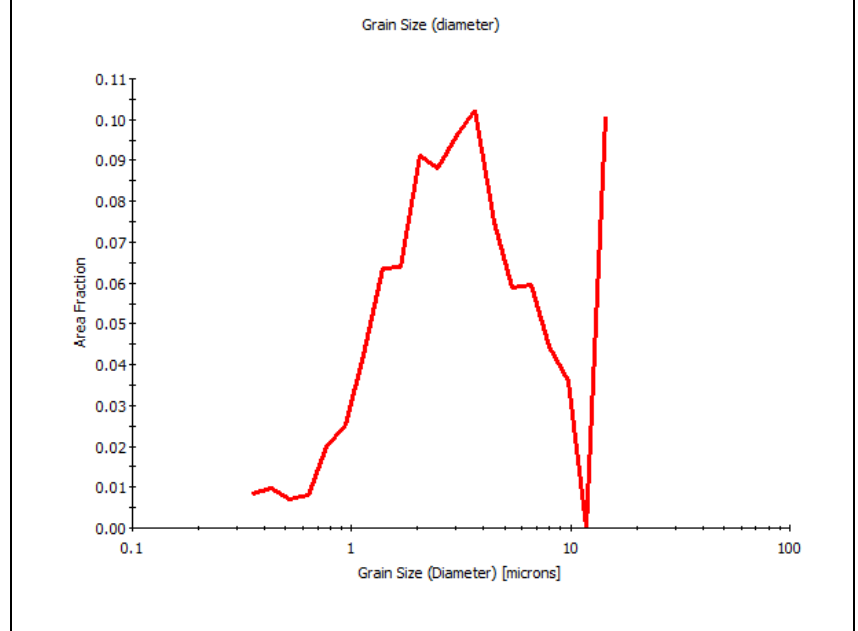
Figure 19 . Grain size ( μ m) with respect to area